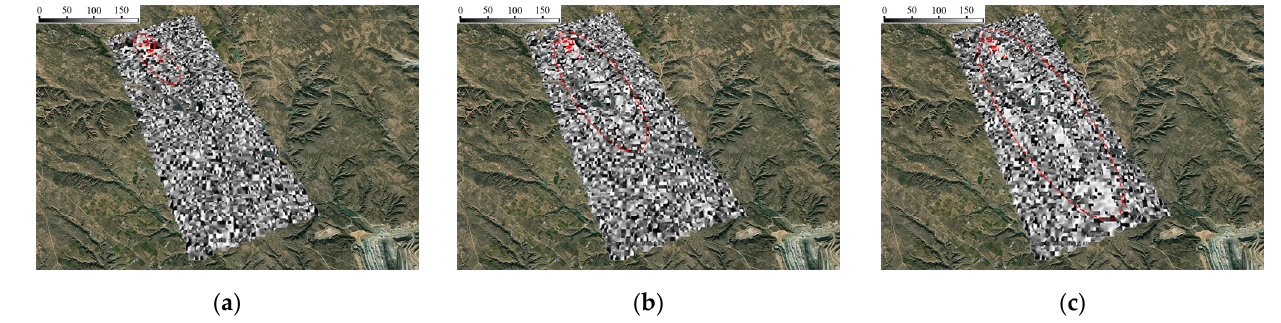
Figure 18. Gradient map of surface deformation : ( a ) Early period (20180810): Cracks at the location of the opencut are distributed in an approximate circle, with a diameter greater than the width of the working face; ( b ) Active period (20190218): the crack gradient distribution map of the surface was developing along the direction of workface advance as the workface continues to advance; ( c ) Downhole stoppage (20190910): the surface deformation gradient map has a general "long strip" distribution.